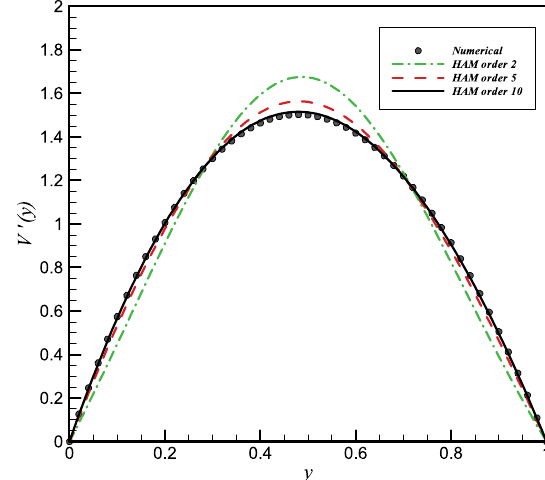
Fig.5. ThebehaviorofthesolutionsRes 10 ( U )obtainedbytheHAM for various (cid:1) when Re = 1 . 0 and Ha = 1 . 0 , [45].